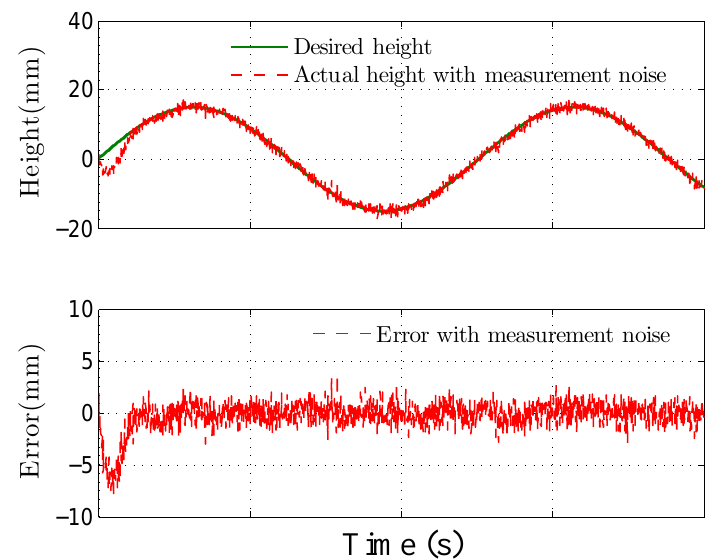
Figure 8. Tracking height and error of quarter vehicle with measurement noise in co-simulation.